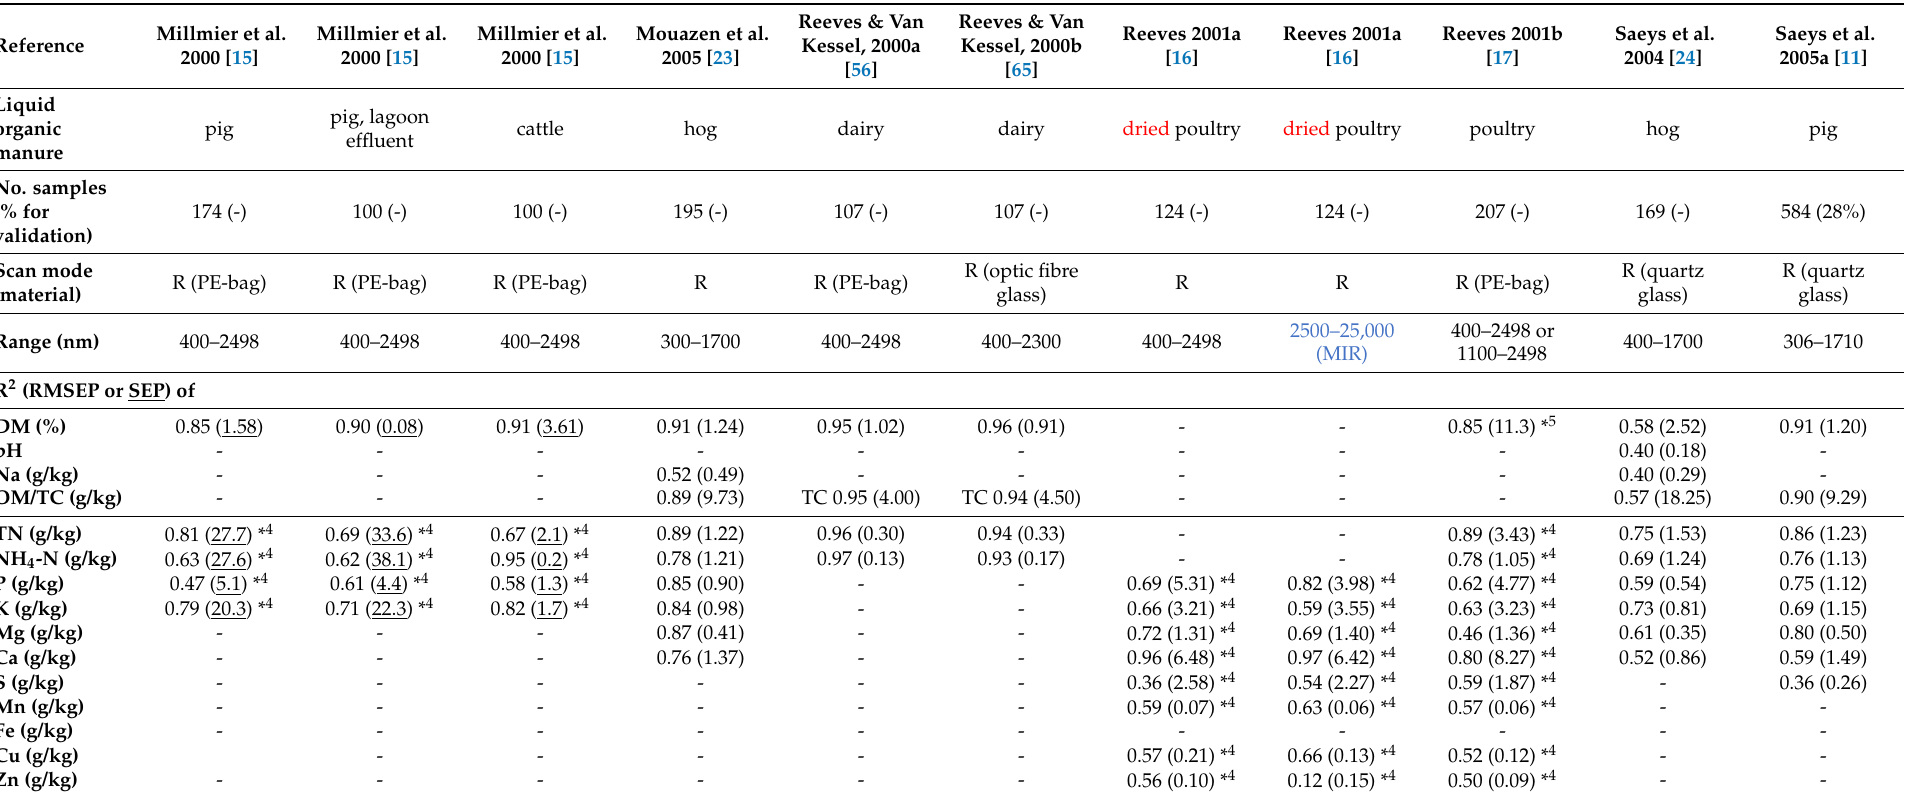
Best values for each parameter are highlighted in bold letters, dried samples in red, MIR technique in blue, and SEP values in underlined letters. Scan mode: R = reflectance; Parameters: DM = dry matter, EC = electrical conductivity, OM = organic matter, TC = total carbon, TN= total nitrogen; R 2 = coefficient of determination, RMSEP = root mean squared error of prediction, SEP = standard error of prediction. * 4 On DM basis. * 5 DM calculated from parameter moisture (m) by DM = 1 −